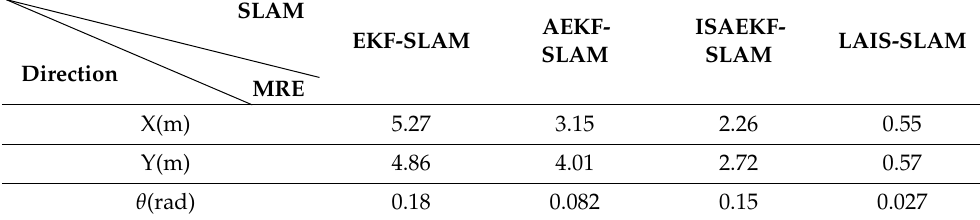
Table 2. The MRE of each algorithm in three directions.